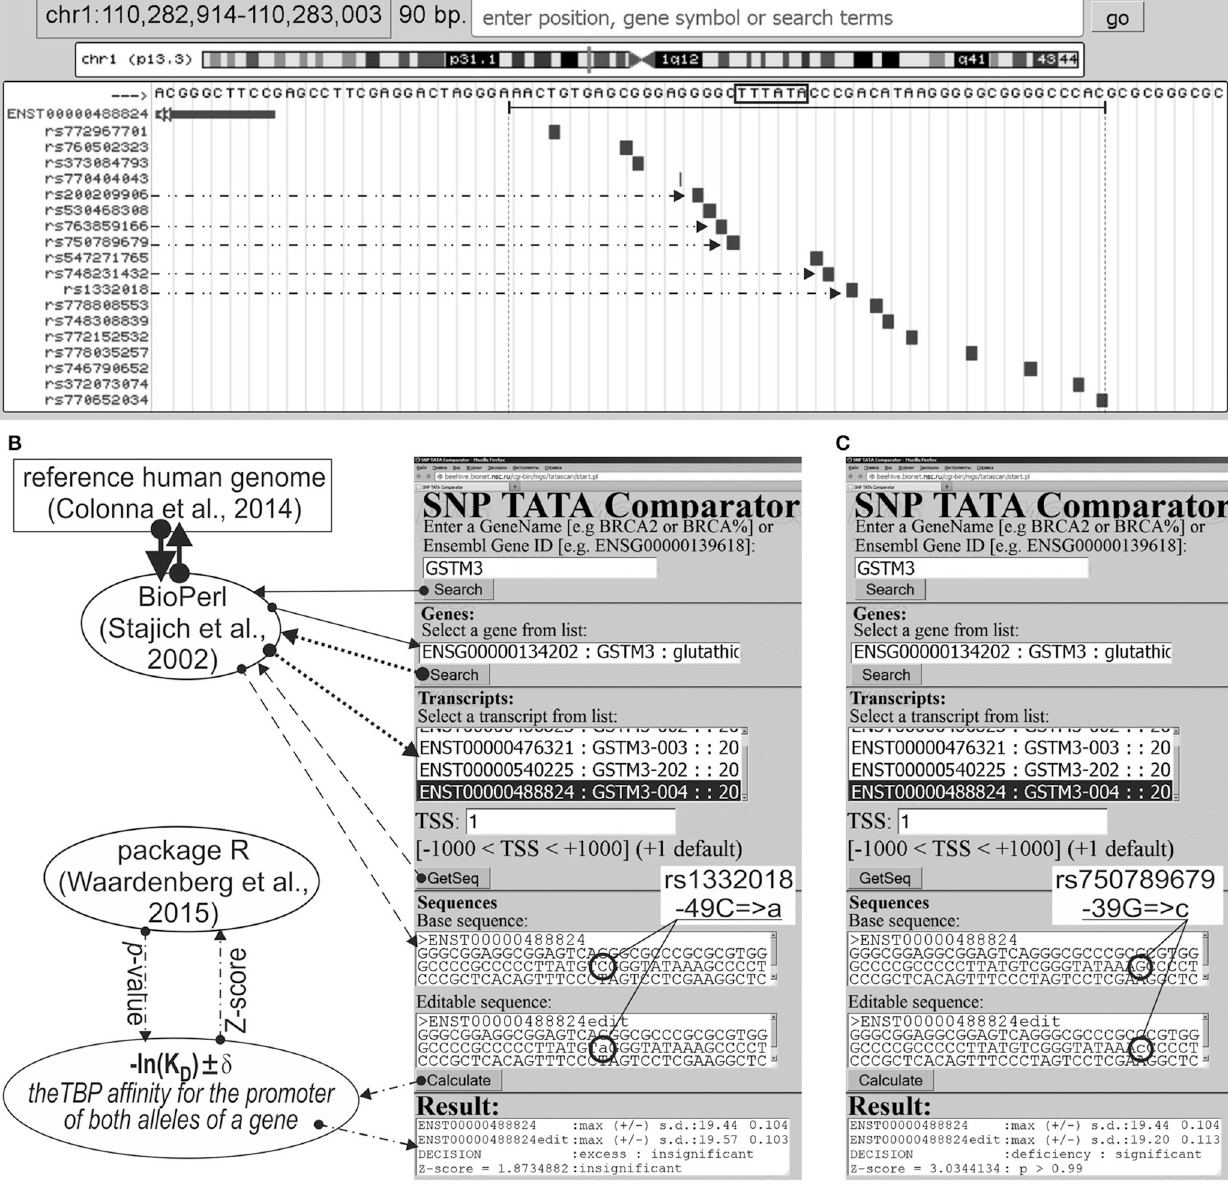
Frontiers in Aging Neuroscience | www.frontiersin.org